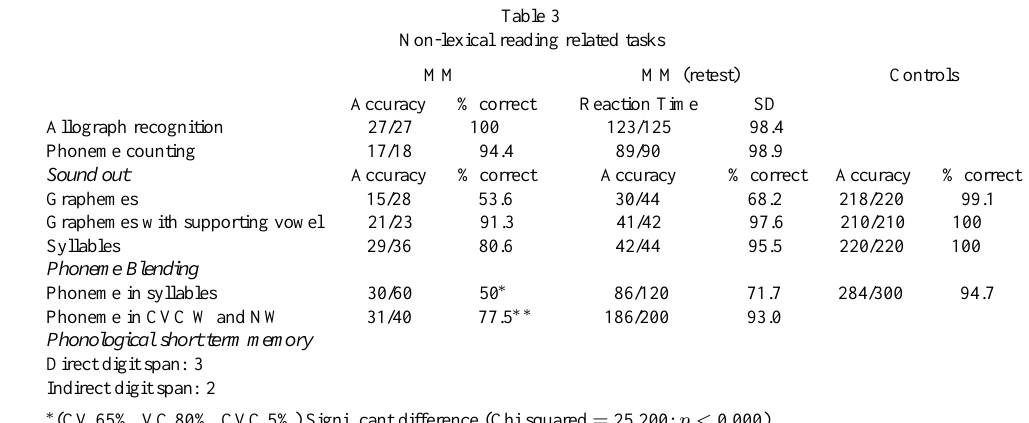
Table 3 Non-lexical reading related